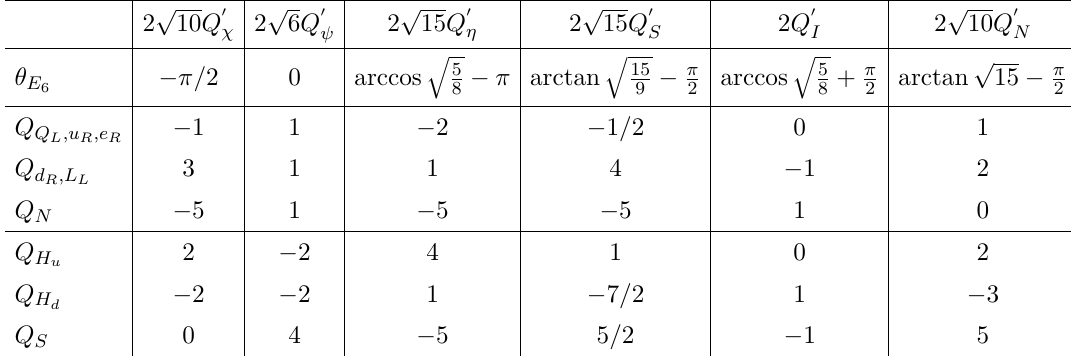
Table 1 . U(1) 0 charges of the quarks, leptons, and Higgs states in six commonly-studied U(1) 0 extensions of the SM that could arise from the breaking of a E 6 GUT symmetry. We additionally present the value of the mixing angle θ E ∈ [ − π, π ] 6